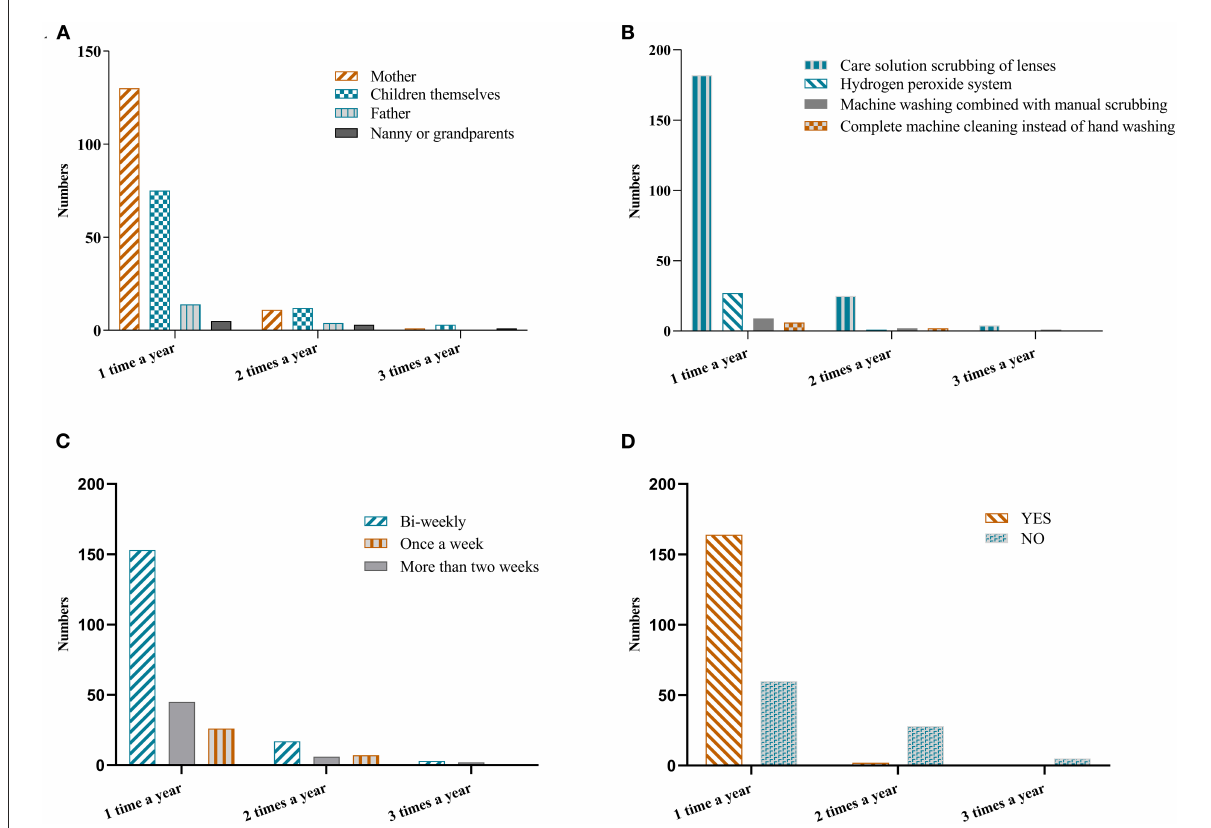
FIGURE2 The frequency of OK lens breakage and the daily care regimen. (A) Association between the caregiver and frequency of OK lens breakage. (B) Association between the care method and frequency of OK lens breakage. (C) Association between the frequency of protein removal and OK lens breakage. (D) Association between whether lenses were cleaned in a timely manner after removal and OK lens